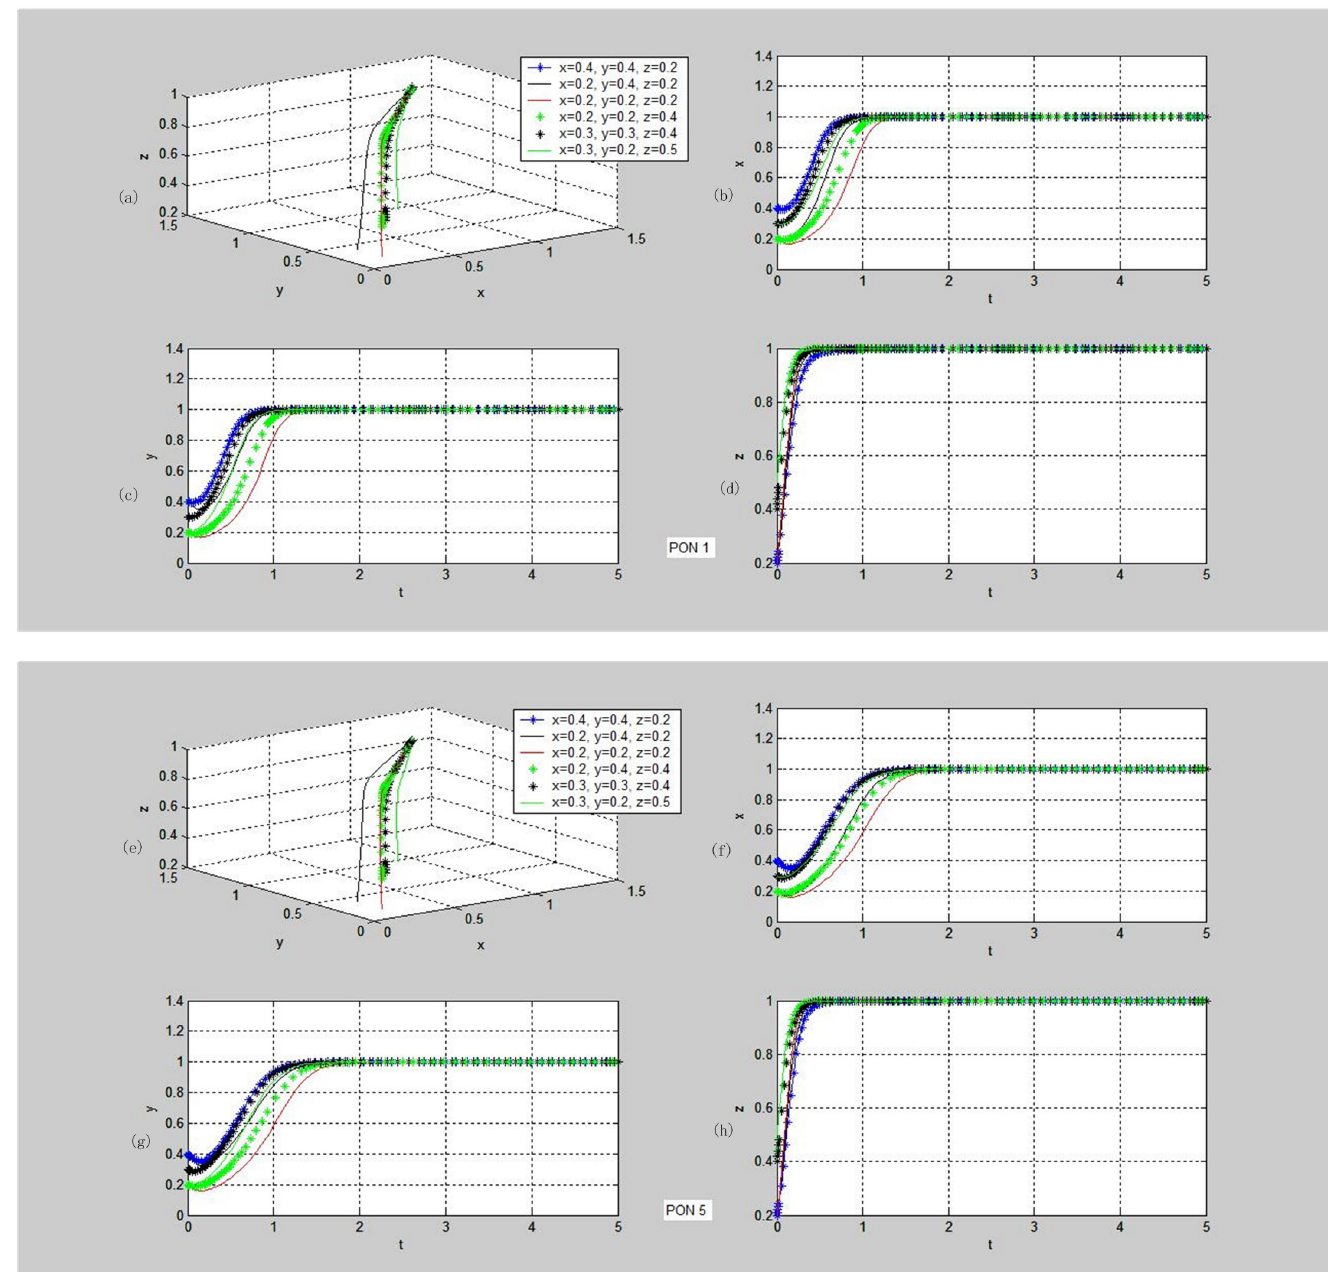
Fig 5. Evolutionary dynamics of strategies stable in (cooperation, cooperation, supervision). PON-Proposition. (a)~(d) demonstrate the phase trajectories of x, y, z and (x, y, z) in the game situations shown in Proposition 1: (a) The phase trajectory of (x, y, z) of the entire evolutionary game system over time t; (b) the dynamic evolution characteristic of x, i.e., the proportion of individuals choosing Cooperation strategy in population PPP over time t; (c) the dynamic evolution characteristic of y, i.e., the proportion of individuals choosing Cooperation strategy in population DC over time t; (d) the dynamic evolution characteristic of z, i.e., the proportion of individuals choosing Supervision strategy in population TPIP over time t. (e)~(h) demonstrate the phase trajectories of x, y, z and (x, y, z) in the game situations shown in Proposition 5: (e) The phase trajectory of (x, y, z) of the entire evolutionary game system over time t; (f) the dynamic evolution characteristic of x, i.e., the proportion of individuals choosing Cooperation strategy in population PPP over time t; (g) the dynamic evolution characteristic of y, i.e., the proportion of individuals choosing Cooperation strategy in population DC over time t; (h) the dynamic evolution characteristic of z, i.e., the proportion of individuals choosing Supervision strategy in population TPIP over time